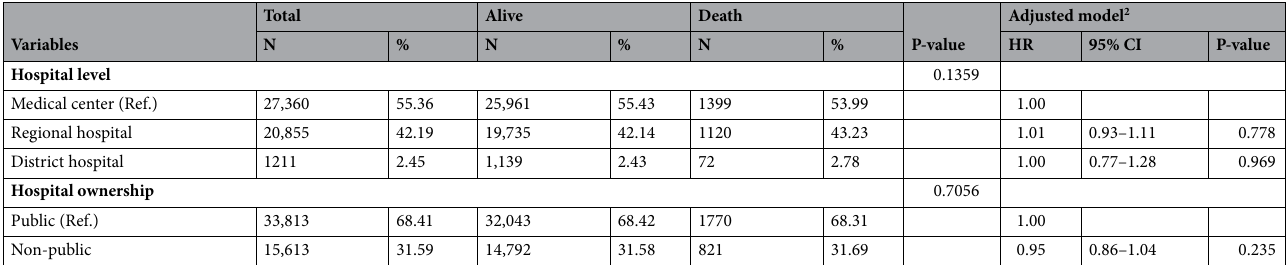
Table 2. Influence of DFTIs and other related factors on mortality risk in patients with confirmed breast cancer. NTD New Taiwan Dollar (USD1≈ NTD30), CCI Charlson comorbidity index, ERA estrogen receptor assay, PRA progesterone receptor assay, HER2 human epidermal growth factor receptor 2, RT radiotherapy, Chemo chemotherapy, HT hormone therapy, TT targeted therapy. 1 Exclusion of cancer from the CCI score. 2 The Cox proportional hazard model was also controlled for relevant variables including marital status,